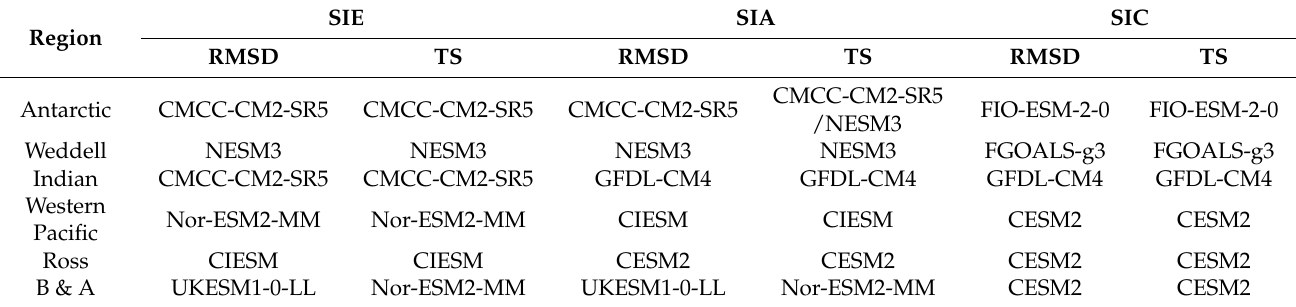
Table 3. Comparison of the most reasonable prediction of SIE, SIA, and SIC based on RMSD and TS in the whole Antarctic and five